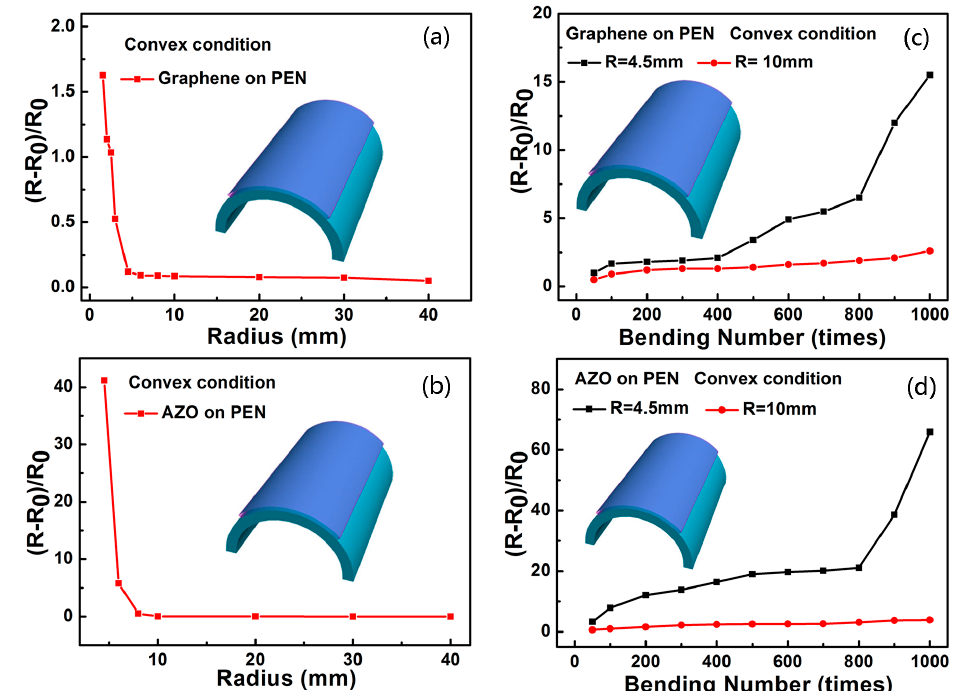
Figure 5. Variation of sheet resistance of ( a ) graphene and ( b ) AZO in convex conditions with different bending radii. Variation of sheet resistance of ( c ) graphene and ( d ) AZO in convex conditions with different bending numbers at a radius of 4.5 and 10 mm, respectively.